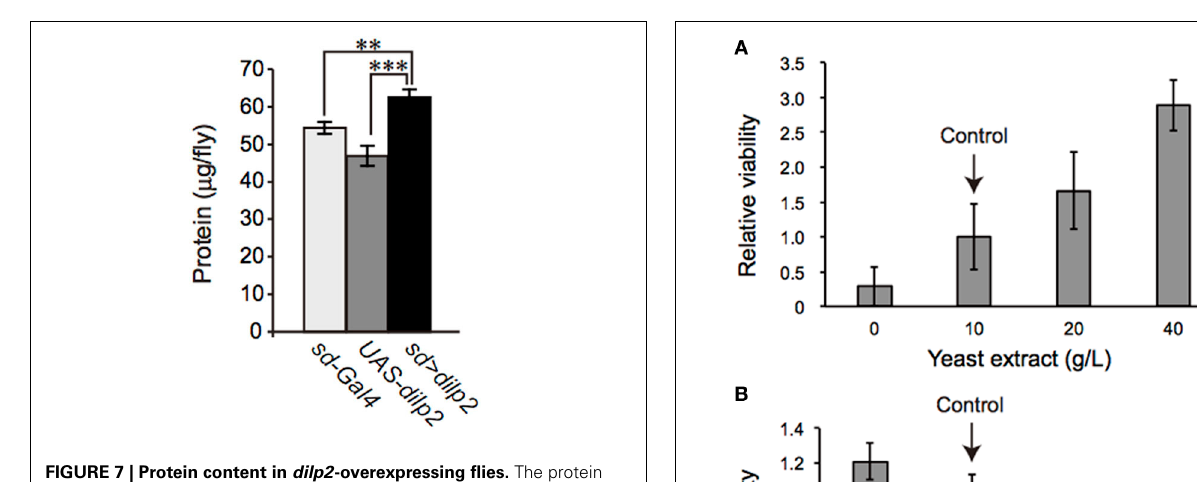
FIGURE 7 | Protein content in dilp2 -overexpressing flies. The protein content was significantly increased in the dilp2 - overexpressing flies ( sd > dilp2 ) compared to the parental lines ( sd-Gal4 and UAS-dilp2 ) as controls. Results are shown as the mean ± SE of at least three experiments.